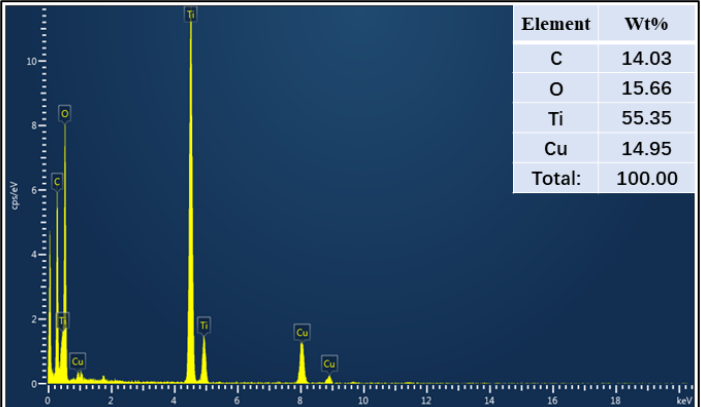
Figure 4. EDX of colored anatase nanocrystals.